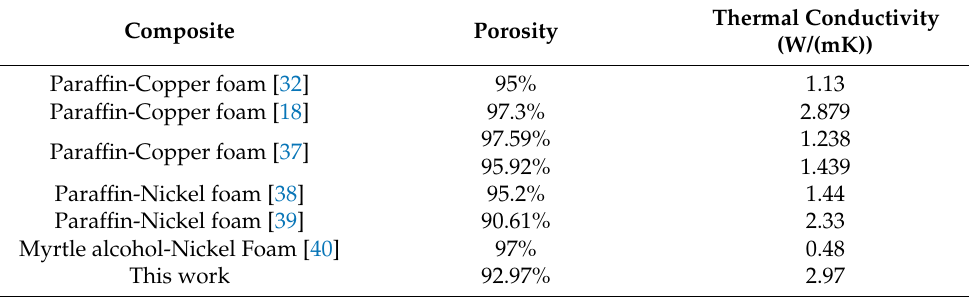
Table 1. Comparison of the prepared PCM composite with other reported